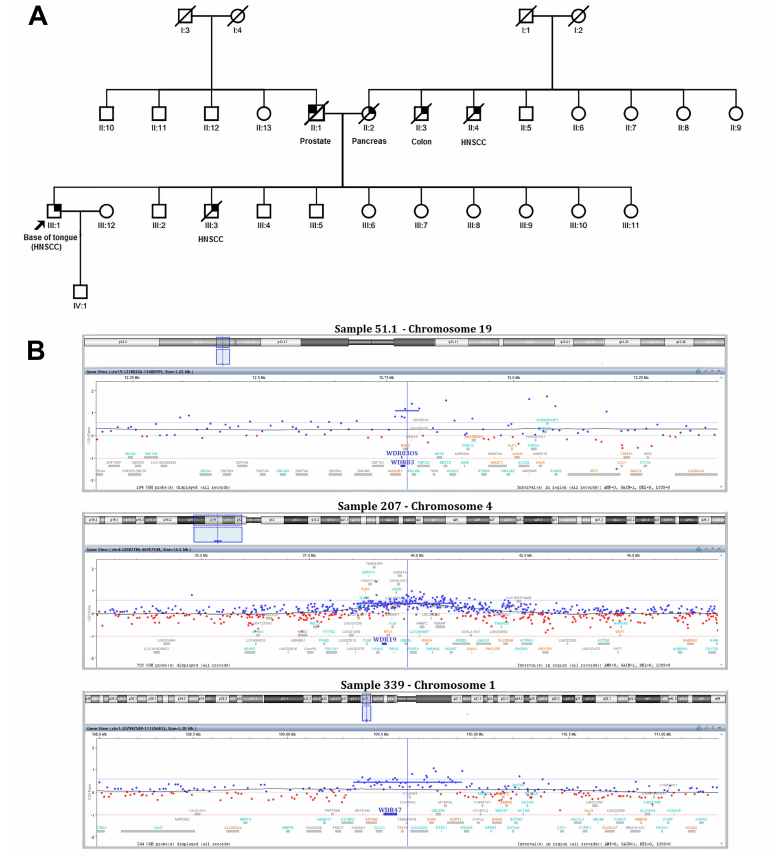
Figure 1. ( A ). Pedigree of one family showing two generations of patients with head and neck cancer (II:4 and III:3) and other tumor types, in relatives of the index patient (III:1). ( B ). Graphical representation of the gains encompassing the genes of the WDR